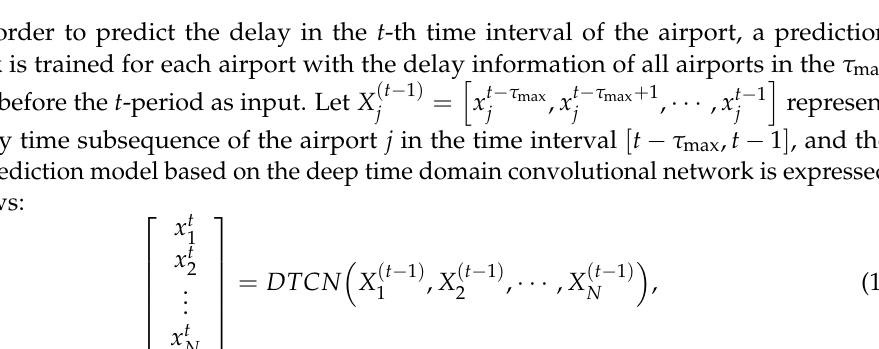
Figure 5. The DTCN prediction model architecture based on the attention